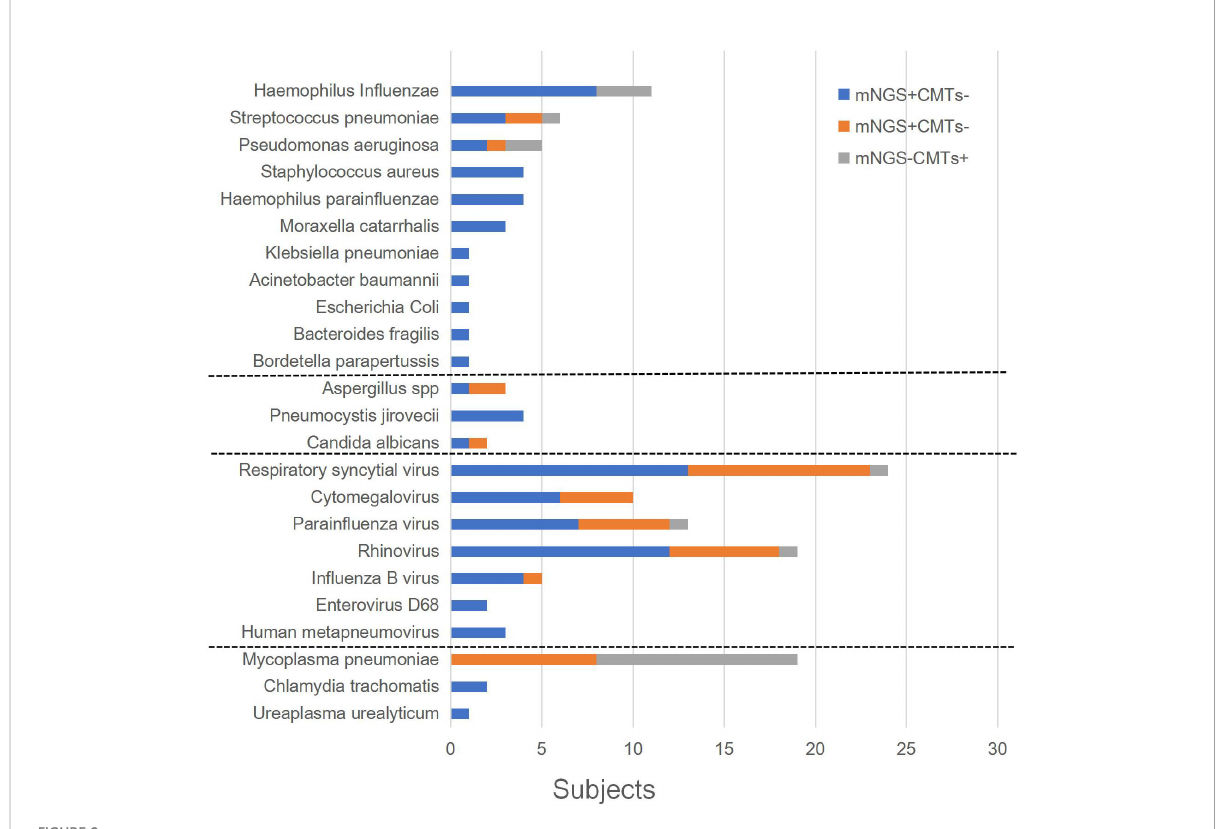
FIGURE 2 Distribution of pathogens identi fi ed by CMT versus